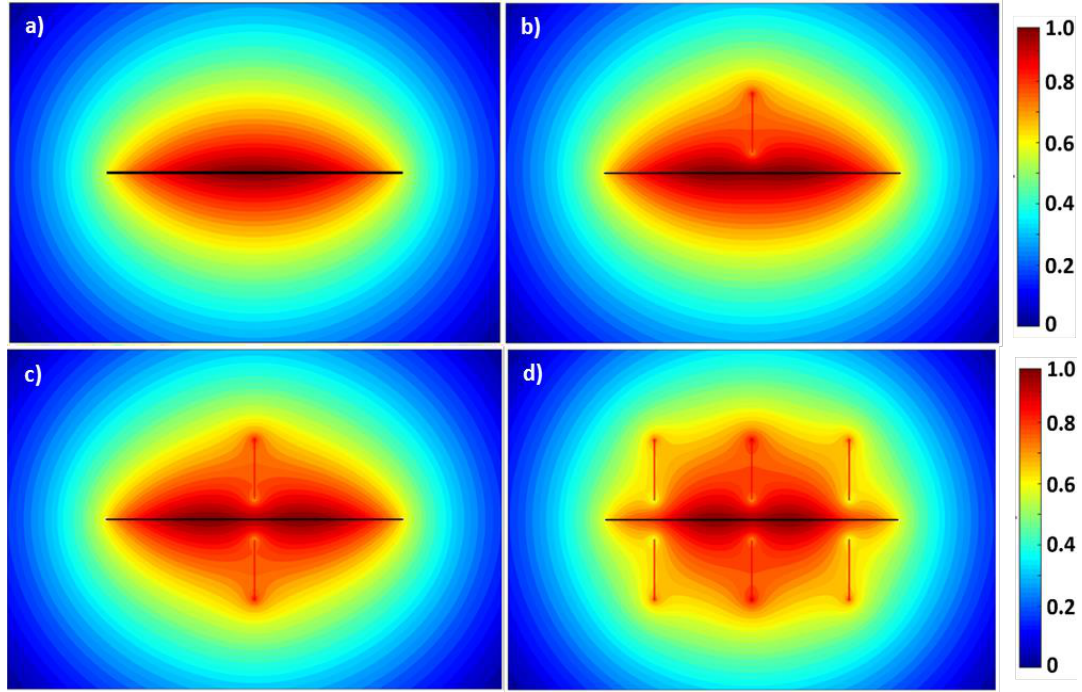
Figure 15. ( a ) Pressure field around a single hydraulic fracture in a homogenous reservoir with no natural fractures ( b ) Pressure field with the presence of one natural fracture ( c ) Pressure field with two natural fractures on either side of hydraulic fracture ( d ) Pressure field with six natural fracture with three on either side of the hydraulic fracture. Hydraulic fracture in black, natural fractures in dashed red line. The pressure scale was